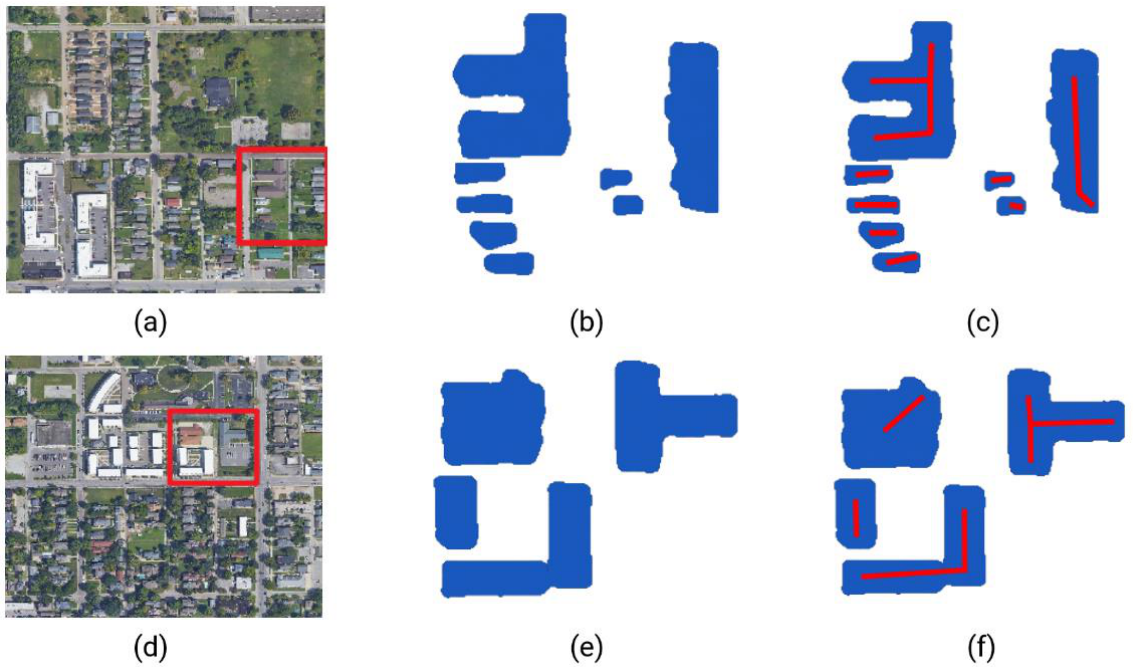
Figure 17. Skeleton line extraction results for T-shaped and F-shaped buildings. ( a ) High-resolution remote sensing images. The highlighted red box area in ( a ) corresponds to ( b , c ); ( b ) initially extracted vector buildings; ( c ) skeleton line extraction results based on the proposed VRDI approach as shown by the red solid line; ( d ) High-resolution remote sensing images. The highlighted red box area in ( d ) corresponds to ( e , f ); ( e ) initially extracted vector buildings; ( f ) skeleton line extraction results based on the proposed VRDI approach as shown by the red solid line.